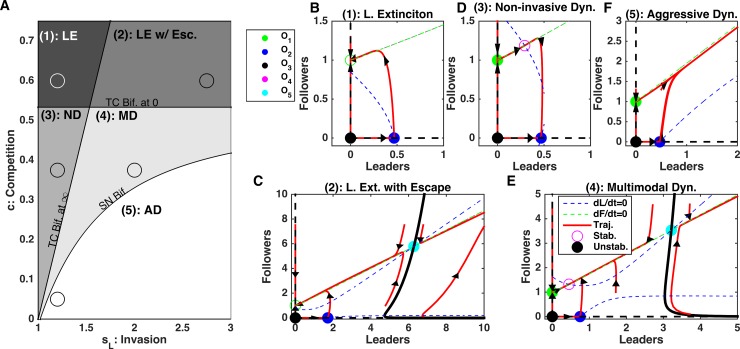
Dynamics of the leader and follower ecosystem.A) Bifurcation diagram sweeping leader population intrinsic feedback strengths, sL, and competition strength, c. Abbreviations—LE: Leader Extinction, LE w/ Esc.: Leader Extinction with Escape, ND: Non-invasive Dynamics, MD: Multimodal Dynamics, AD: Aggressive Dynamics, TC Bif. at ∞: Transcritical Bifurcation at infinity (see Methods), TC Bif. at 0: Transcritical Bifurcation at zero (see Methods), SN Bif.: Saddle Node Bifurcation (see Methods). B-E) Phase diagrams for each regime identified in A). Dashed blue and green lines are null-clines for the leaders and followers, respectively. Red curves show the trajectories of the leader-follower system from different initial conditions, with arrows denoting tangent vectors at various points. Open circles denote stable equilibrium points, stars denote unstable equilibria. Specific sL and c parameters used in panels B-E) are given by the circles in A).